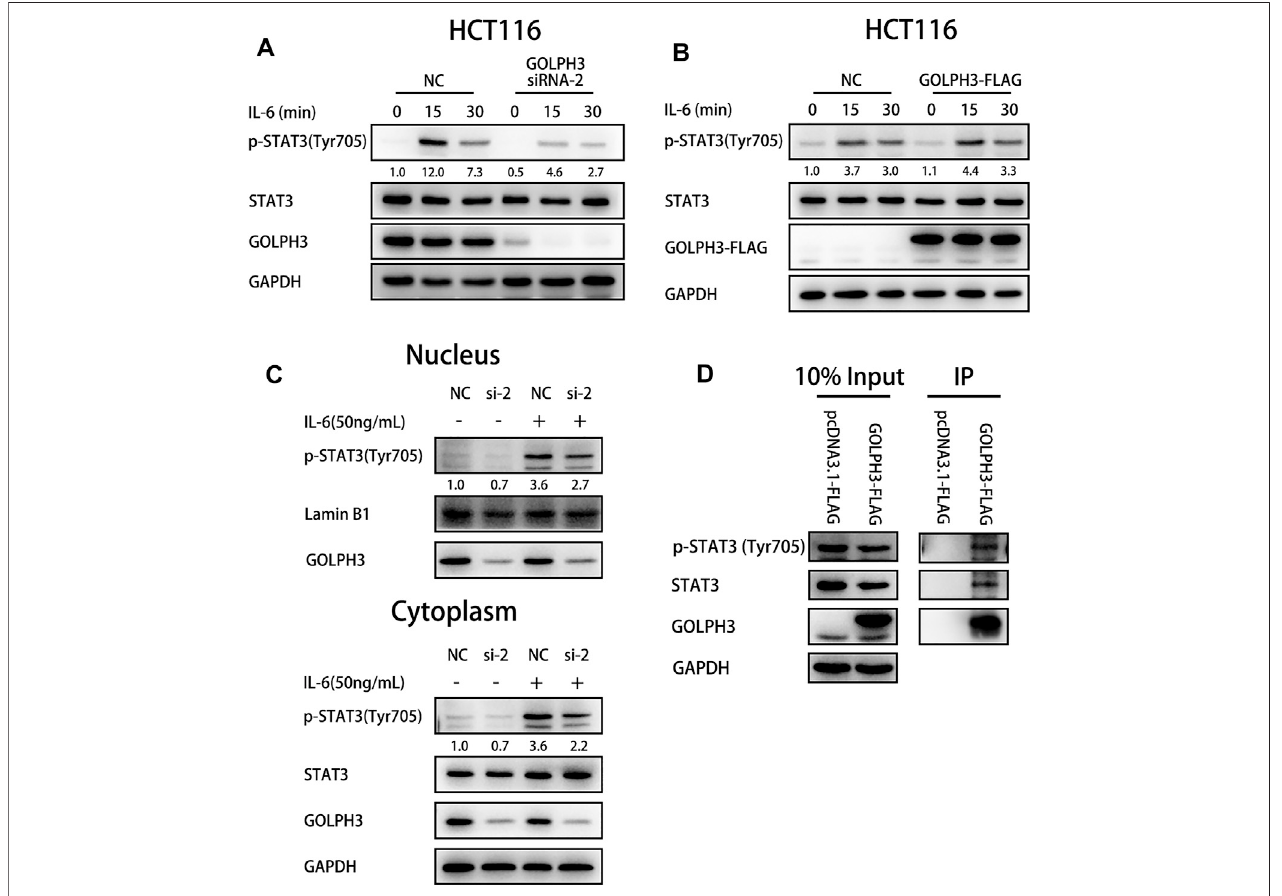
FIGURE 4 | GOLPH3 binds with p-STAT3 to enhance the IL-6 mediated STAT3 activation in HCT116 cells. (A) Loss of GOLPH3 suppressed the Tyr705 phosphorylation of STAT3 in HCT116 cells after IL-6 (20 ng/ml) treatment for the indicated times. (B) Overexpression of GOLPH3 enhanced the phosphorylation of STAT3 in HCT116 cells after IL-6 (20 ng/ml) treatment for the indicated times. (C) HCT116 cells were serum-starved overnight and treated with IL-6 (50 ng/ml) for 30 min. The cells were subjected to nuclear and cytoplasmic fractionation and proteins were analyzed by western blotting. (D) The co-immunoprecipitation result showed the interaction between GOLPH3 with p-STAT3 and total STAT3 in HCT116 cells. Results were reproduced in three independent experiments, and representative immunoblots are